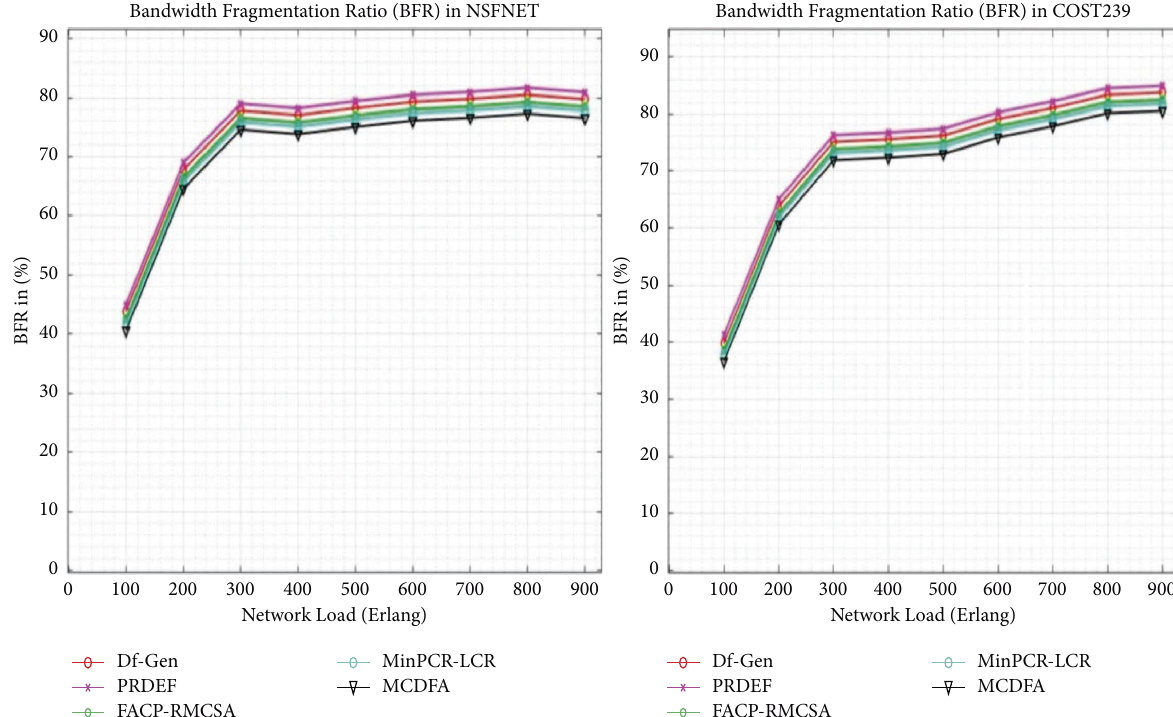
Figure 10: Te bandwidth fragmentation ratio (BFR) for NSFET and COST239.